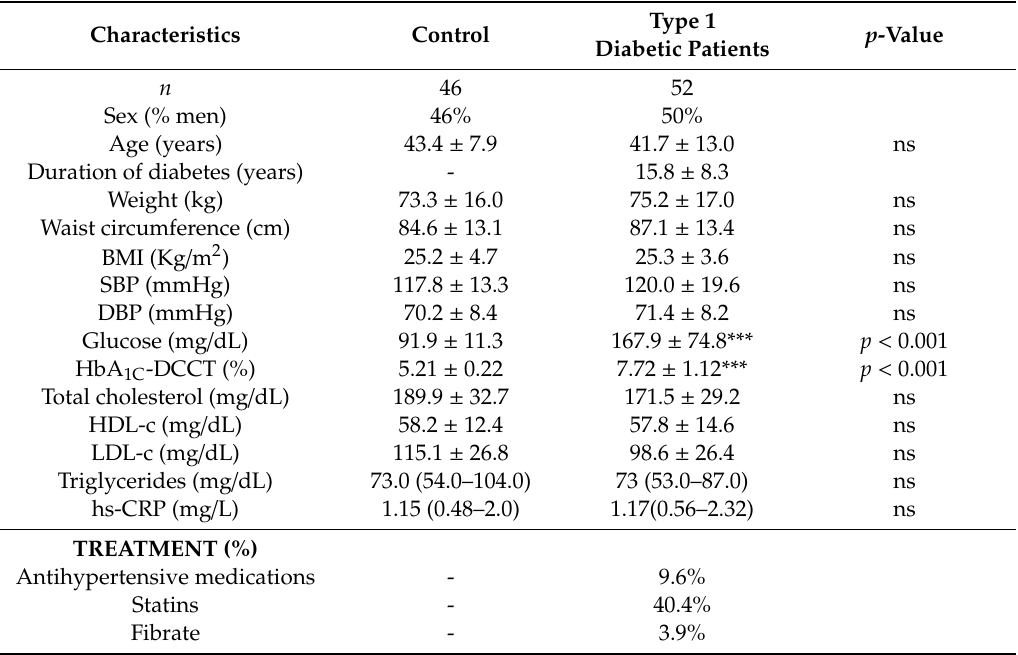
Table 1. Anthropometric characteristics, biochemical determination and pharmacological treatment of the study